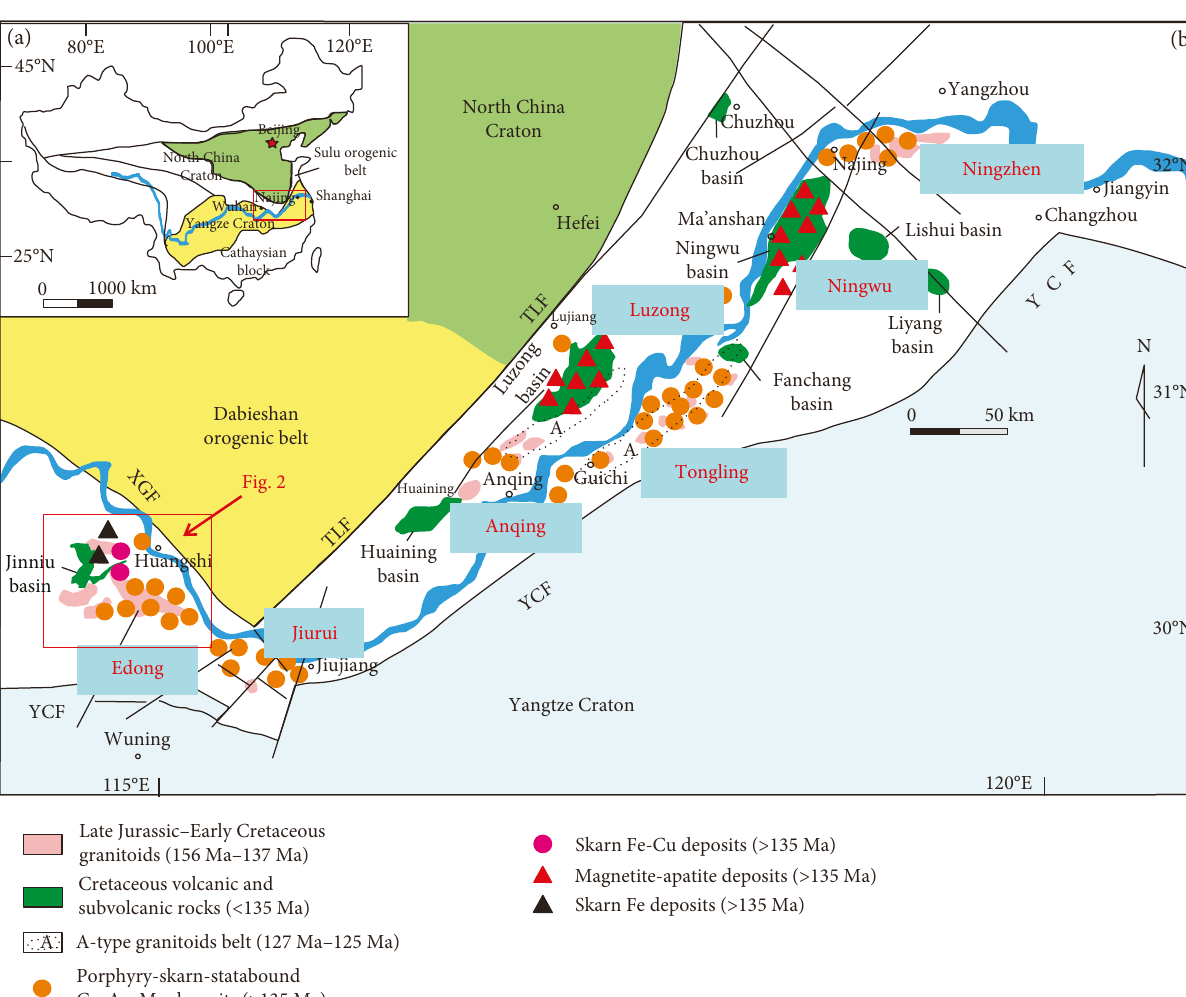
Figure 1: (a) Geotectonic subdivision of China, showing the location of the Middle-Lower Yangtze River Metallogenic Belt (MLYRMB); (b) regional geological map of the MLYRMB illustrating the distribution of di ff erent ore districts (modi fi ed after [28]). TLF =Tancheng-Lujiang Fault; XGF =Xiangfan-Guangji Fault; YCF=Yangxin-Changzhou